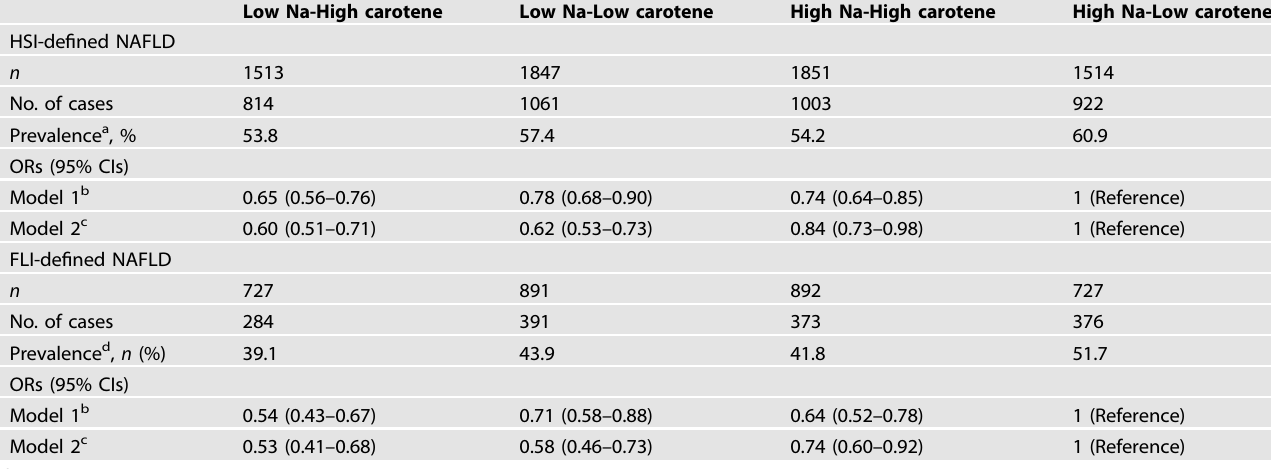
Table 2. Odds ratio (OR) and 95% con fi dence interval (CI) for NAFLD by the combinations of dietary sodium and β -carotene intakes.